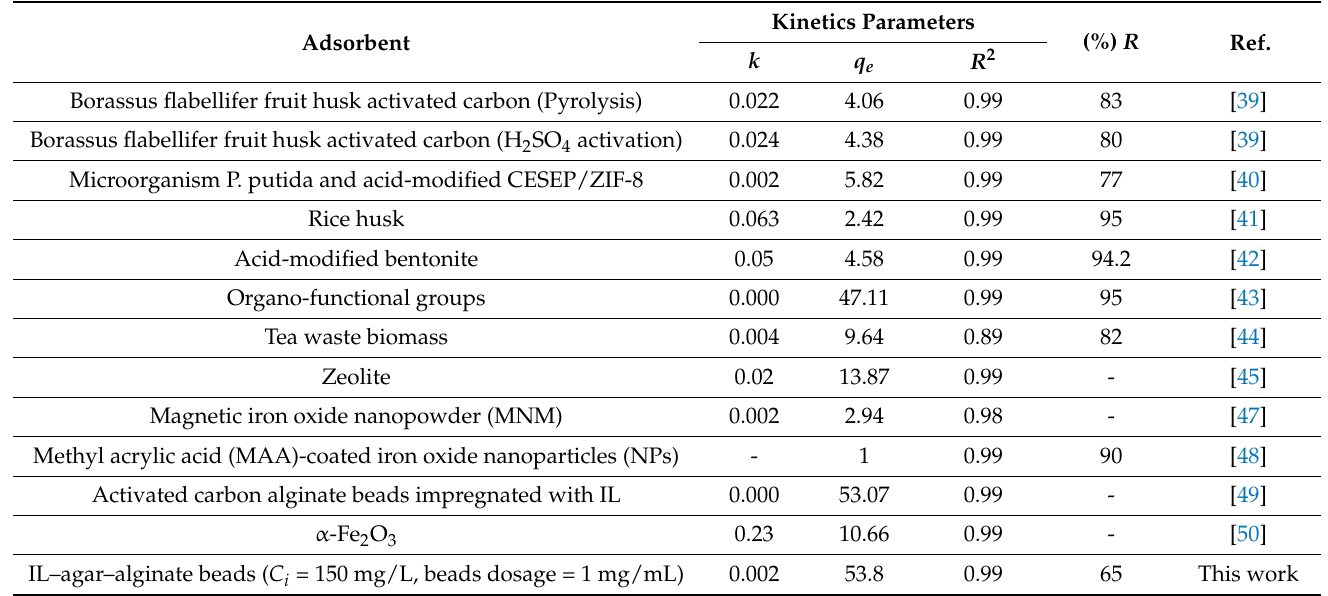
Table 7. Comparison of the removal efficiency and kinetics of IL–agar–alginate beads for phenol removal with previously reported